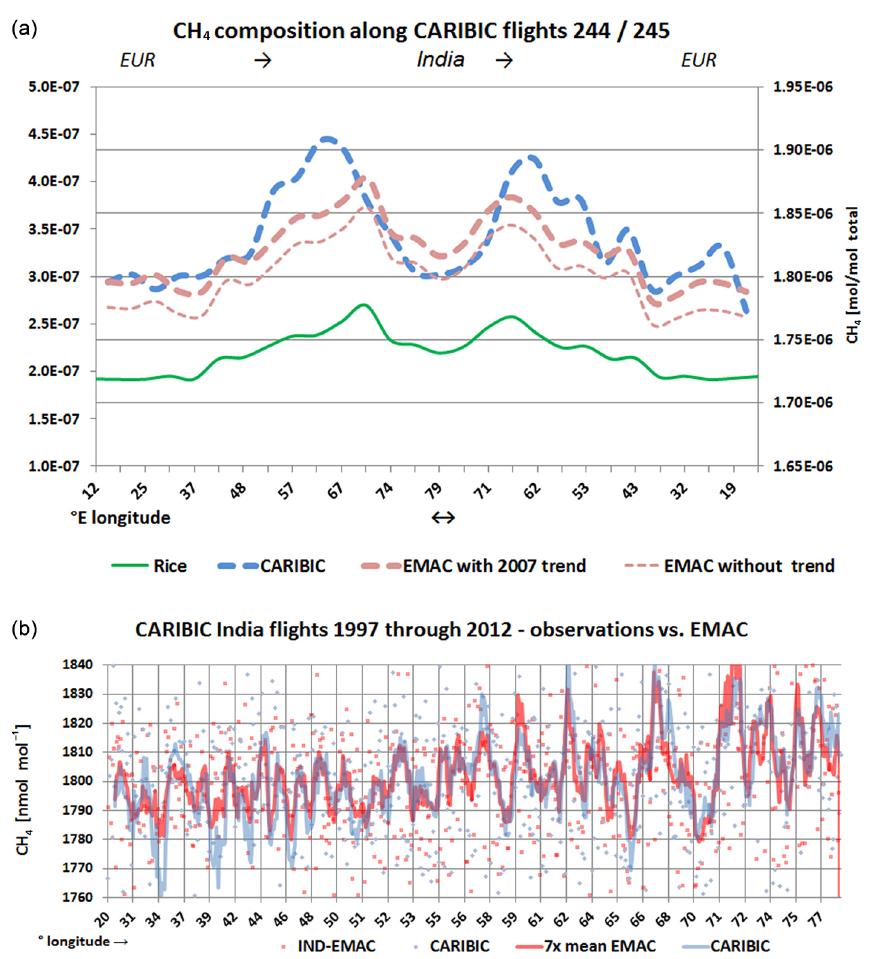
Figure 17. (a) CH 4 mixing ratios observed by CARIBIC (dashed blue, right axis) and calculated by EMAC (thick dashed red) and tagged rice-related CH 4 (green, left axis) – India flights (August 2008). The thin dashed red line marks the simulation without trend period increment for reference. (b) CH 4 mixing ratios (nmolmol − 1 ) observed by CARIBIC (blue) during all India flights (1997–2012) and corresponding EMAC simulations (red). The large scatter requires the sliding average of seven points (solid